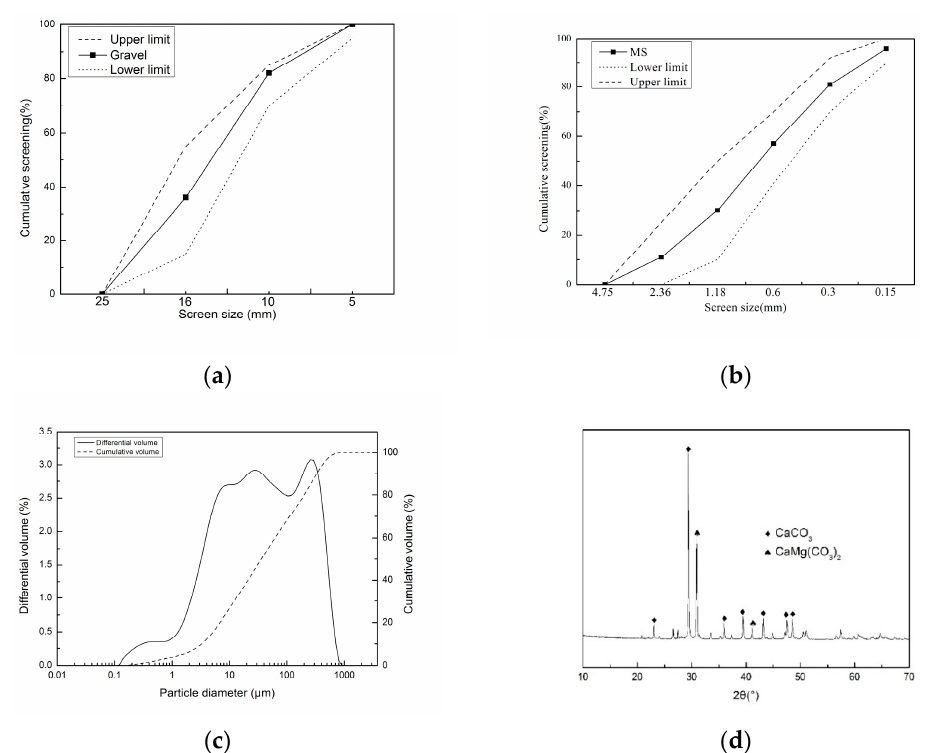
Figure 1. Particle size distribution and XRD: ( a ) particle size distribution of gravel conforming to [48]; ( b ) particle size distribution of machine-made sand (MS) conforming to [49]; ( c ) particle size distribution of aggregate micro fines (AMF), and ( d ) XRD result of AMF.